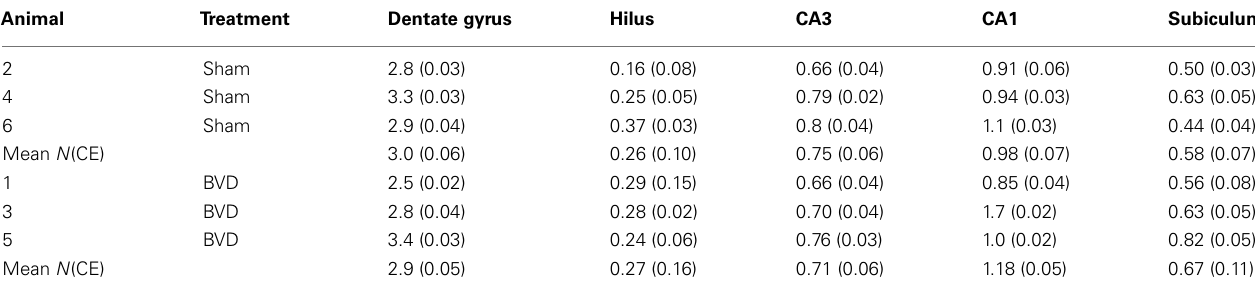
Table 1 |Total number of neurons in different subregions of hippocampus ( × 10 5 ). Animal Treatment Dentate gyrus